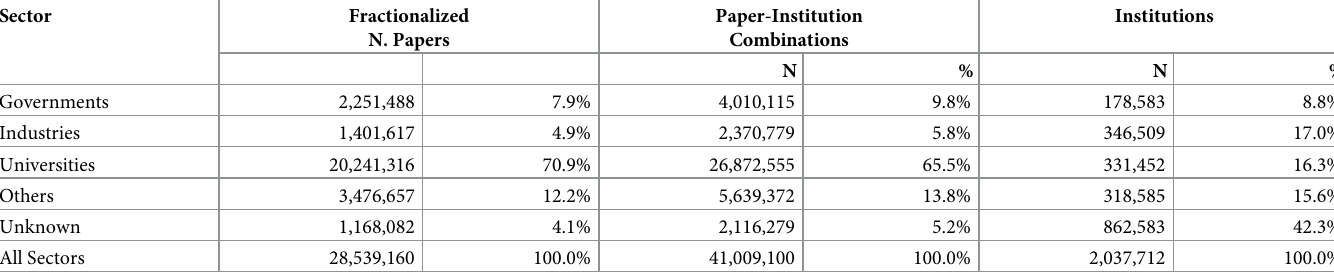
Table 1. Sectoral assignation of fractionalized number of papers, of paper-institution combinations and of distinct institutions. Sector Fractionalized N. Papers